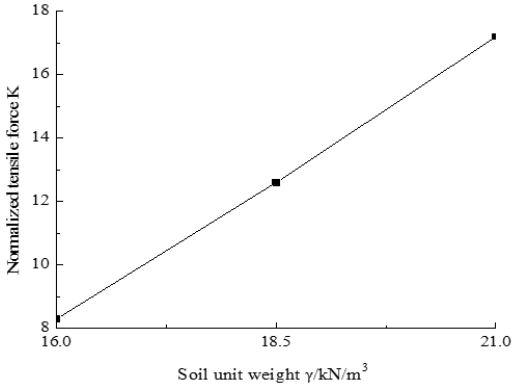
Figure 9. E ff ect of soil unit weight on normalized tensional force of reinforcement.